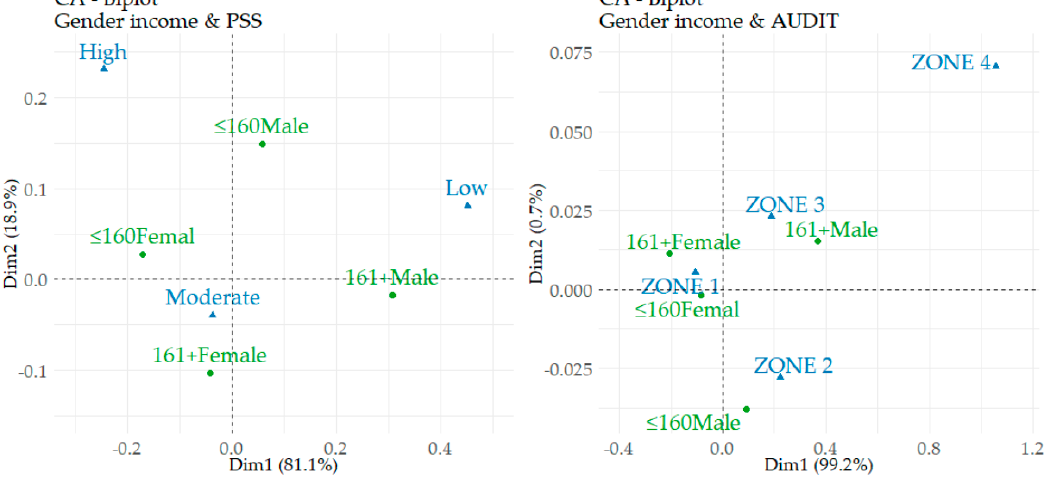
Figure 2. Correspondence analysis map.